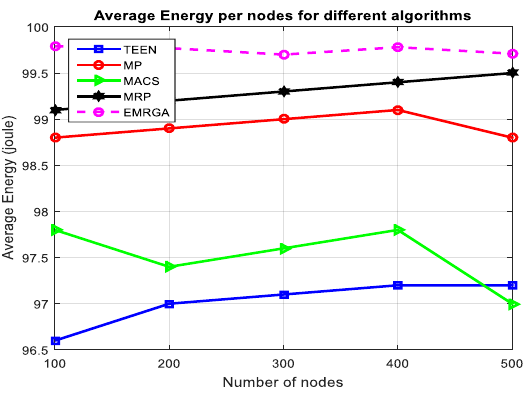
Figure 12. Average